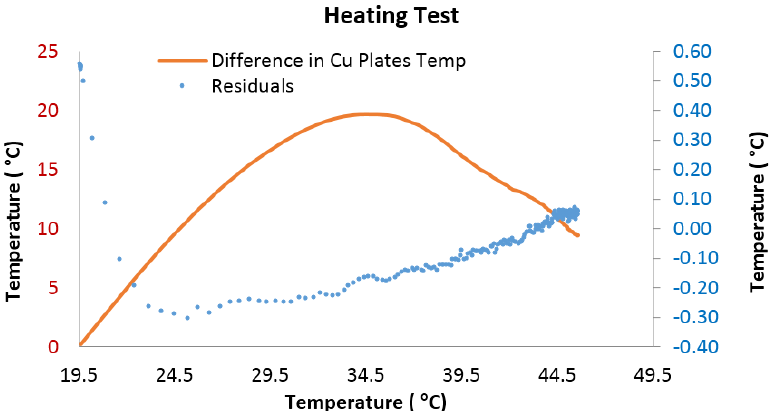
Figure 6. Profile of temperature difference of Cu plates and temperature residuals of fitted curve (heating test, with respect to temperature).